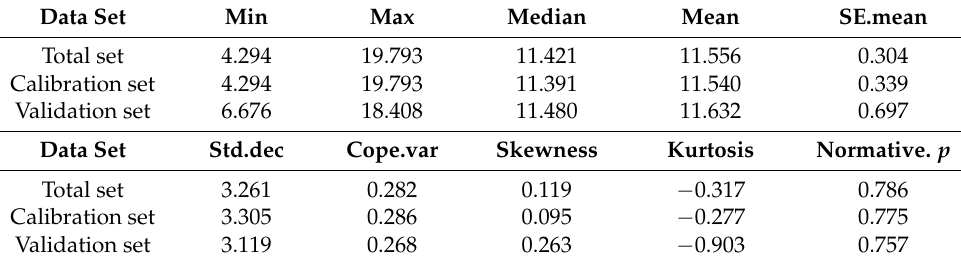
Table 3. Descriptive statistics and normality test for SOC content